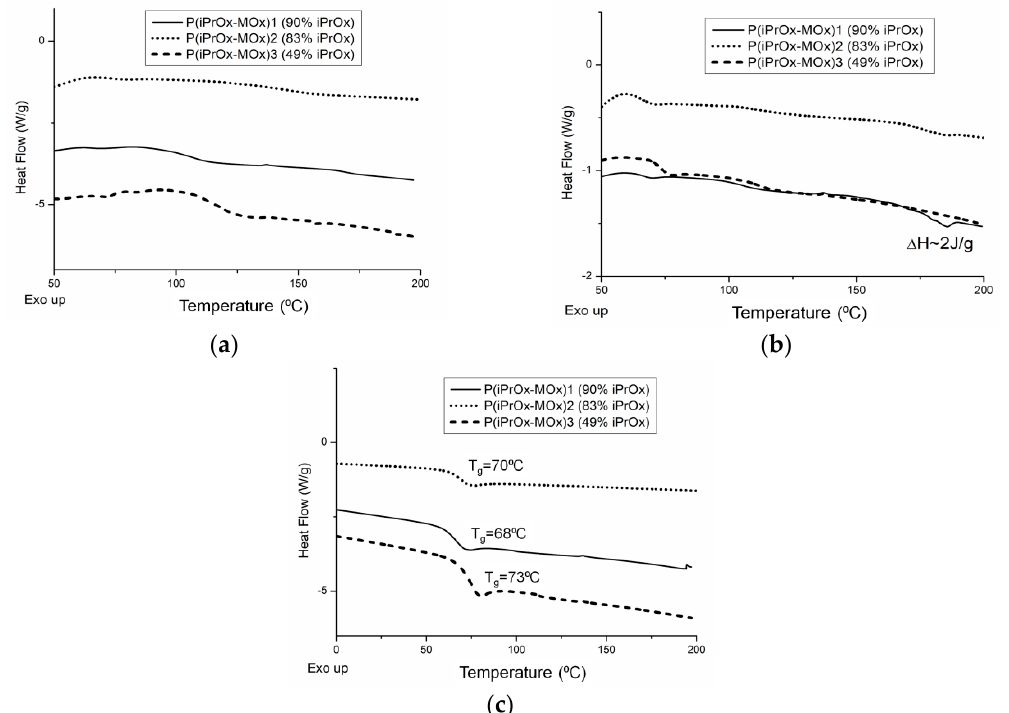
Figure 1. DSC traces for 2-isopropyl-2-oxazoline/2-methyl-2-oxazoline (iPrOx/MOx) copolymers at heating rates of ( a ) 10 °C/min and ( b ) 2.5 °C/min; ( c ) second DSC heating run (10 °C/min) after quenching of copolymers.